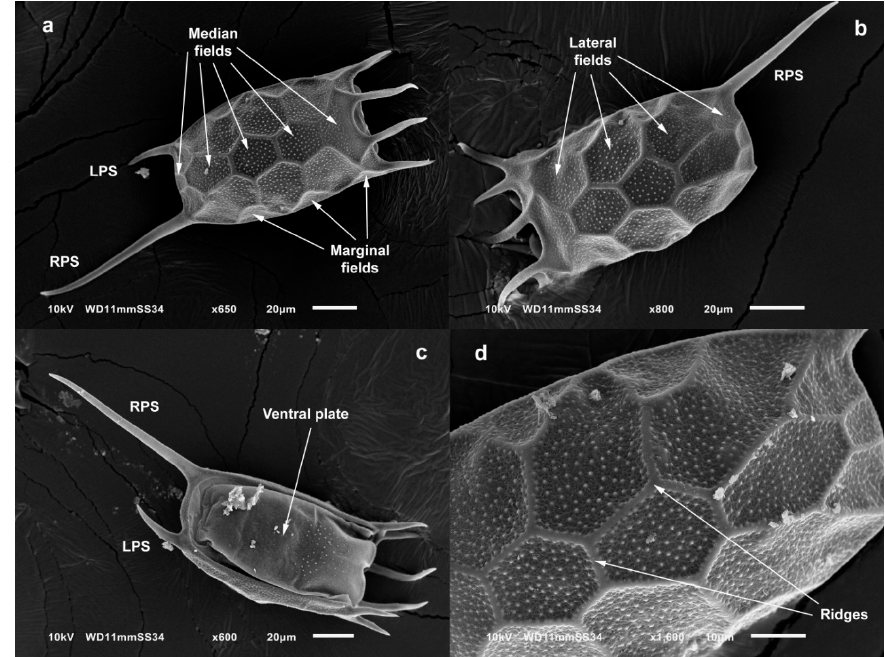
Figure 7. SEM photographs of Keratella tropica from Tepatitlan-Yahualica pond. ( a ). Dorsal view: arrows indicate the median and the marginal fields. ( b ). Dorsal view: arrows indicate lateral fields. ( c ). Ventral view, RPS (Right Posterior Spine), LPS (Left Posterior Spine). ( d ). Dorsal view closeup, arrows indicate a ridge.